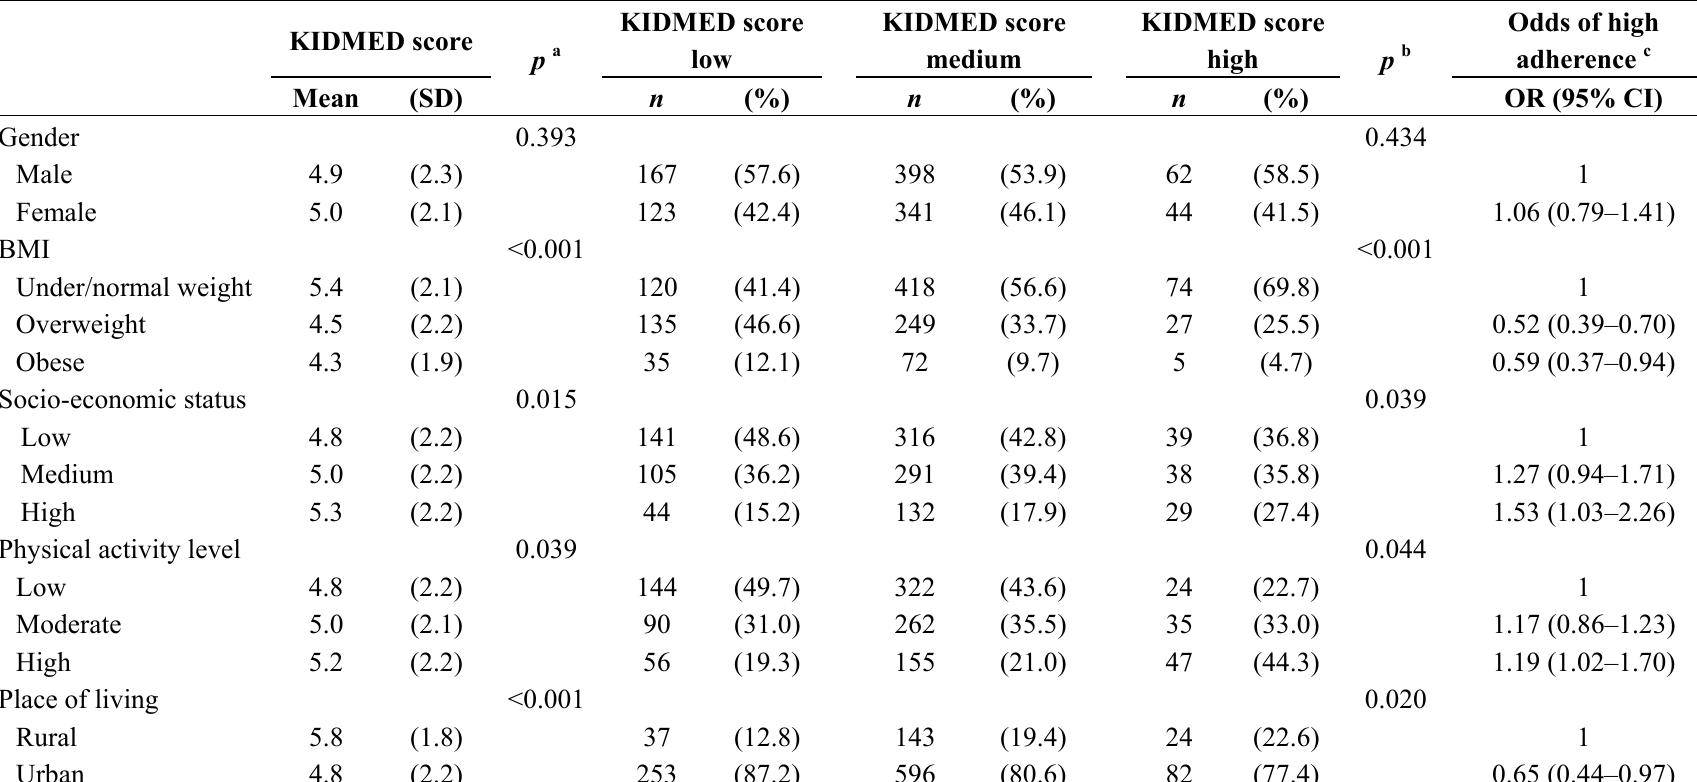
Table 2. Socio-demographic and lifestyle characteristics of the study population, by tertiles of KIDMED diet adherence scores, mean KIDMED scores, and relative odd ratios by multiple logistic regression analysis of factors associated with high adherence to the Mediterranean diet, adjusted for all